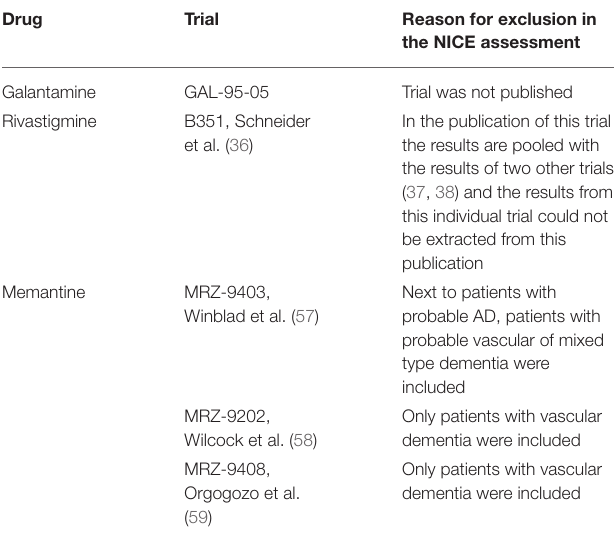
TABLE 2 | Reason of exclusion of phase 3 trials of the marketing authorisation dossiers in the NICE assessment of clinical effectiveness. Drug Trial Reason for exclusion in the NICE